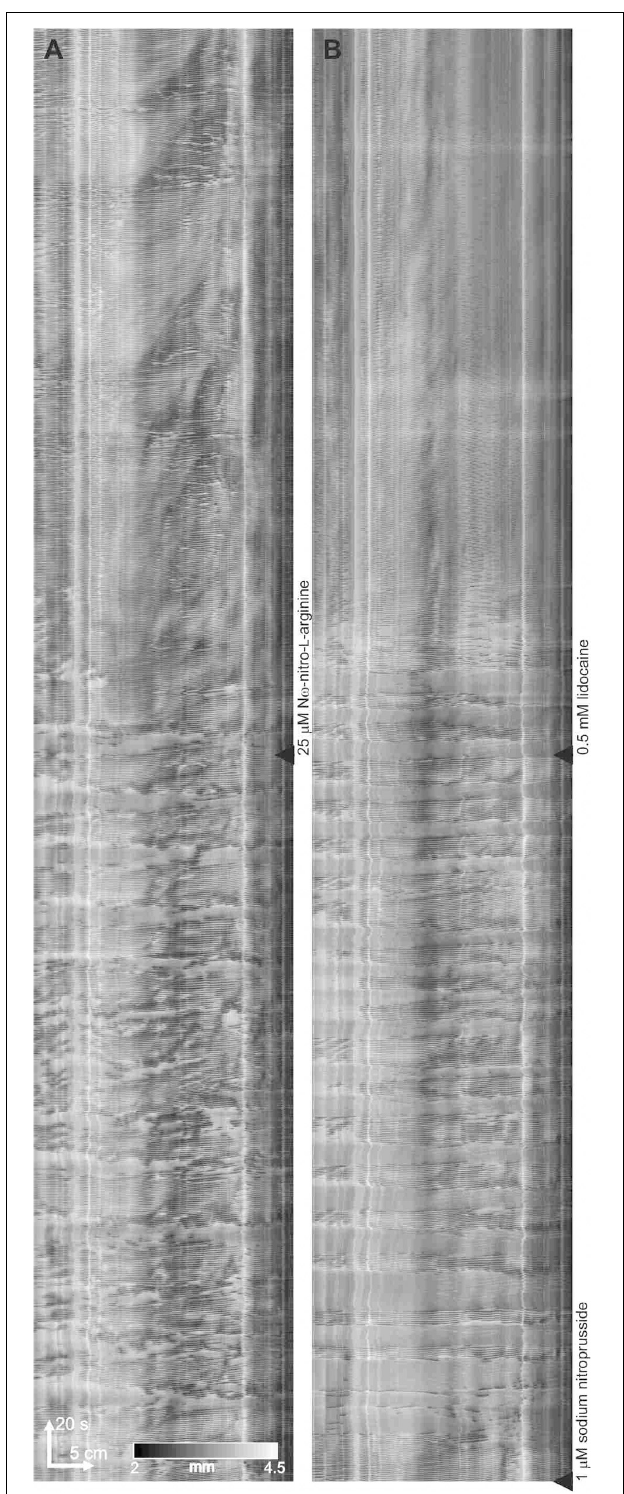
FIGURE 6 | Lidocaine abolishes the minute rhythm induced by SNP in the presence of L-NNA. (A) Effect of L-NNA (added at the black triangle) on a control intestine. (B) At black triangle, 1 µ M SNP was added, followed by